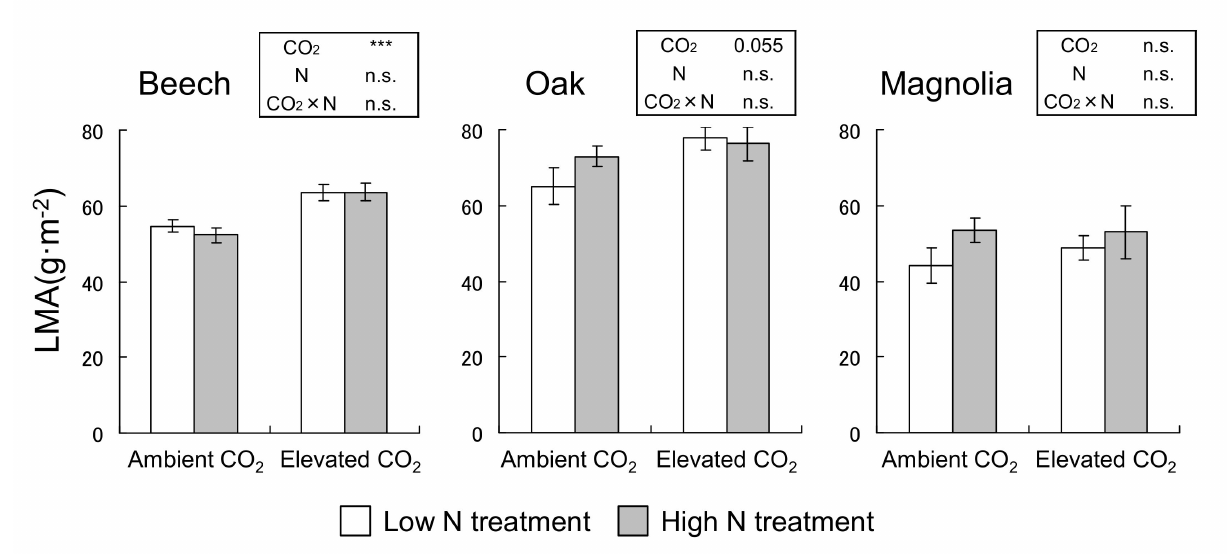
Figure 1. LMA in the leaves of seedlings of three tree species at each treatment. Values are expressed as means ± SE (beech n = 12, oak and magnolia n = 6). The results of the two-way ANOVA are also shown (*** p < 0.001, n.s. p ≥ 0.1). Actual p values are shown when 0.05 < p < 0.10. n.s.; not